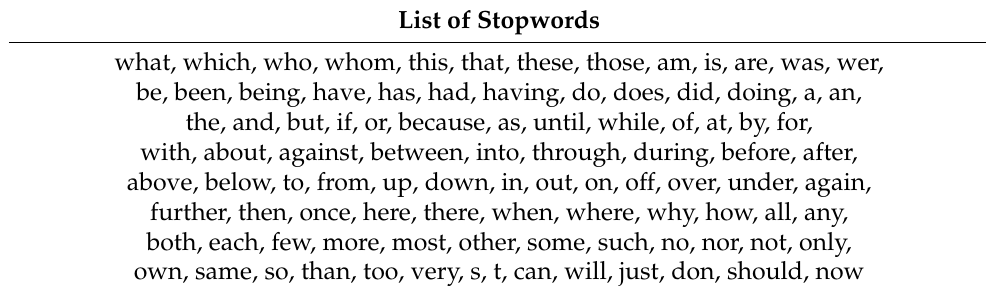
Table 1. List of stopwords used to pre-process the dataset.